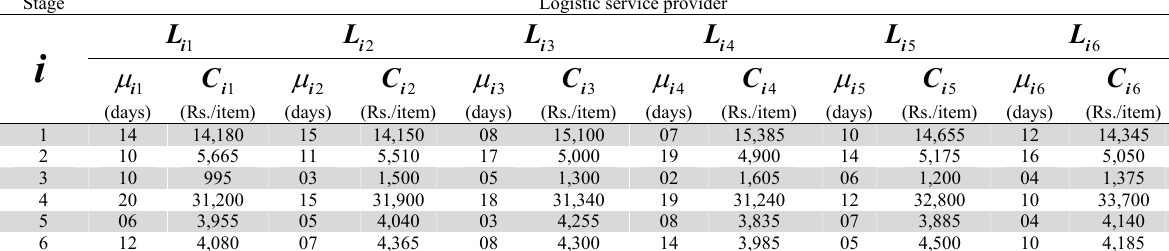
Processing lead times and cost for each service provider at different stages